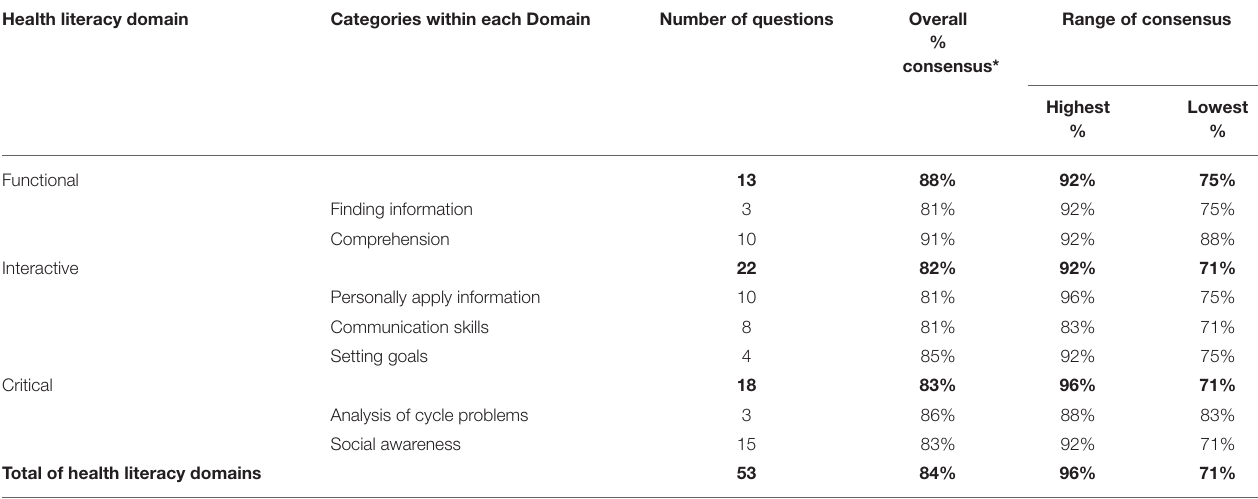
TABLE 4 | Round Three consensus of the draft OM health literacy questionnaire. Health literacy